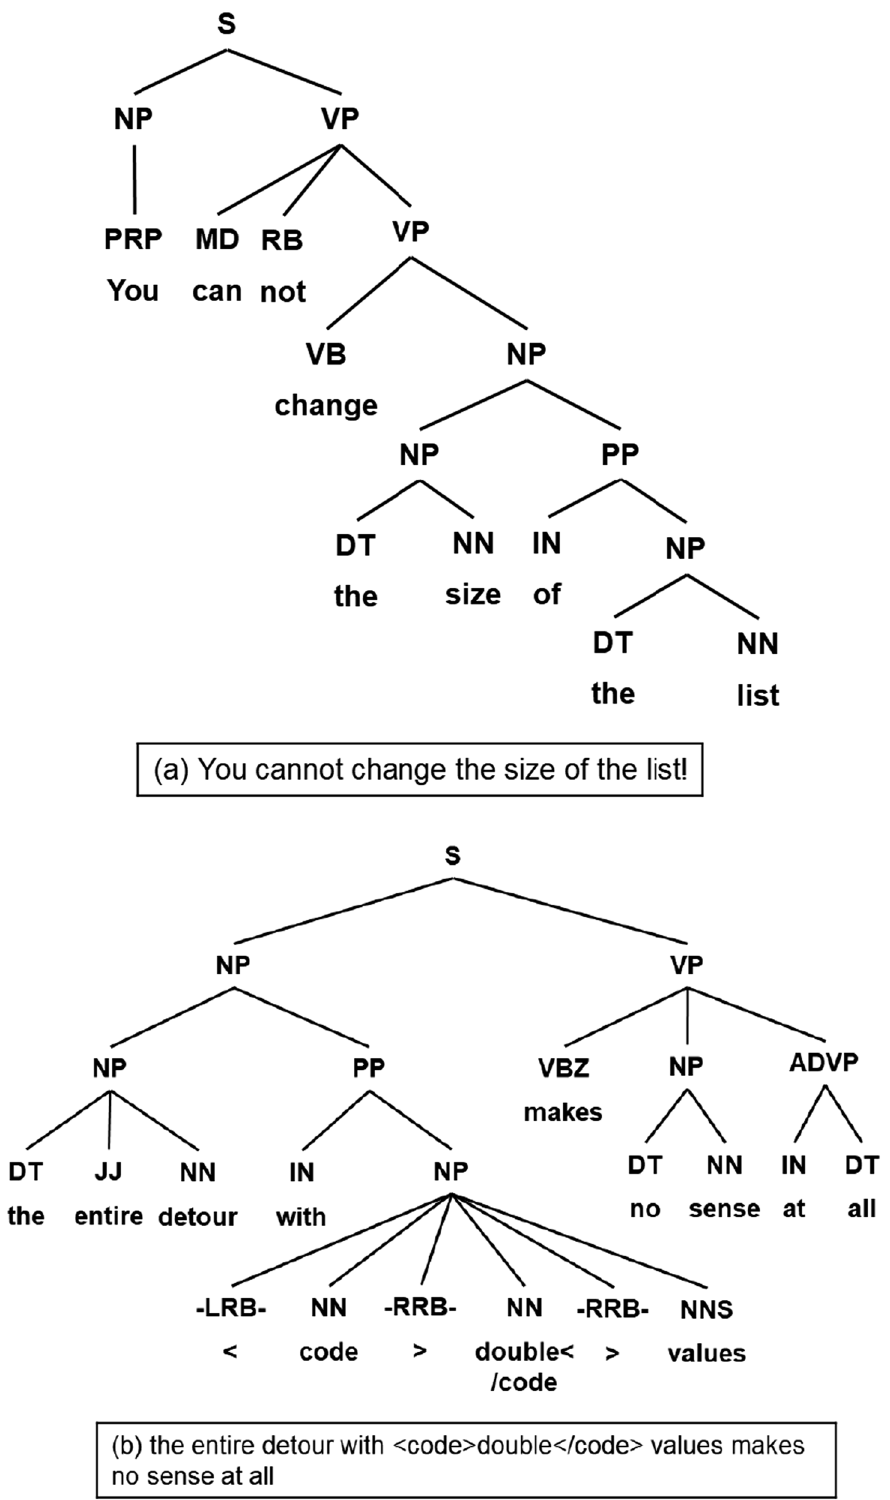
Fig. 4 The example of